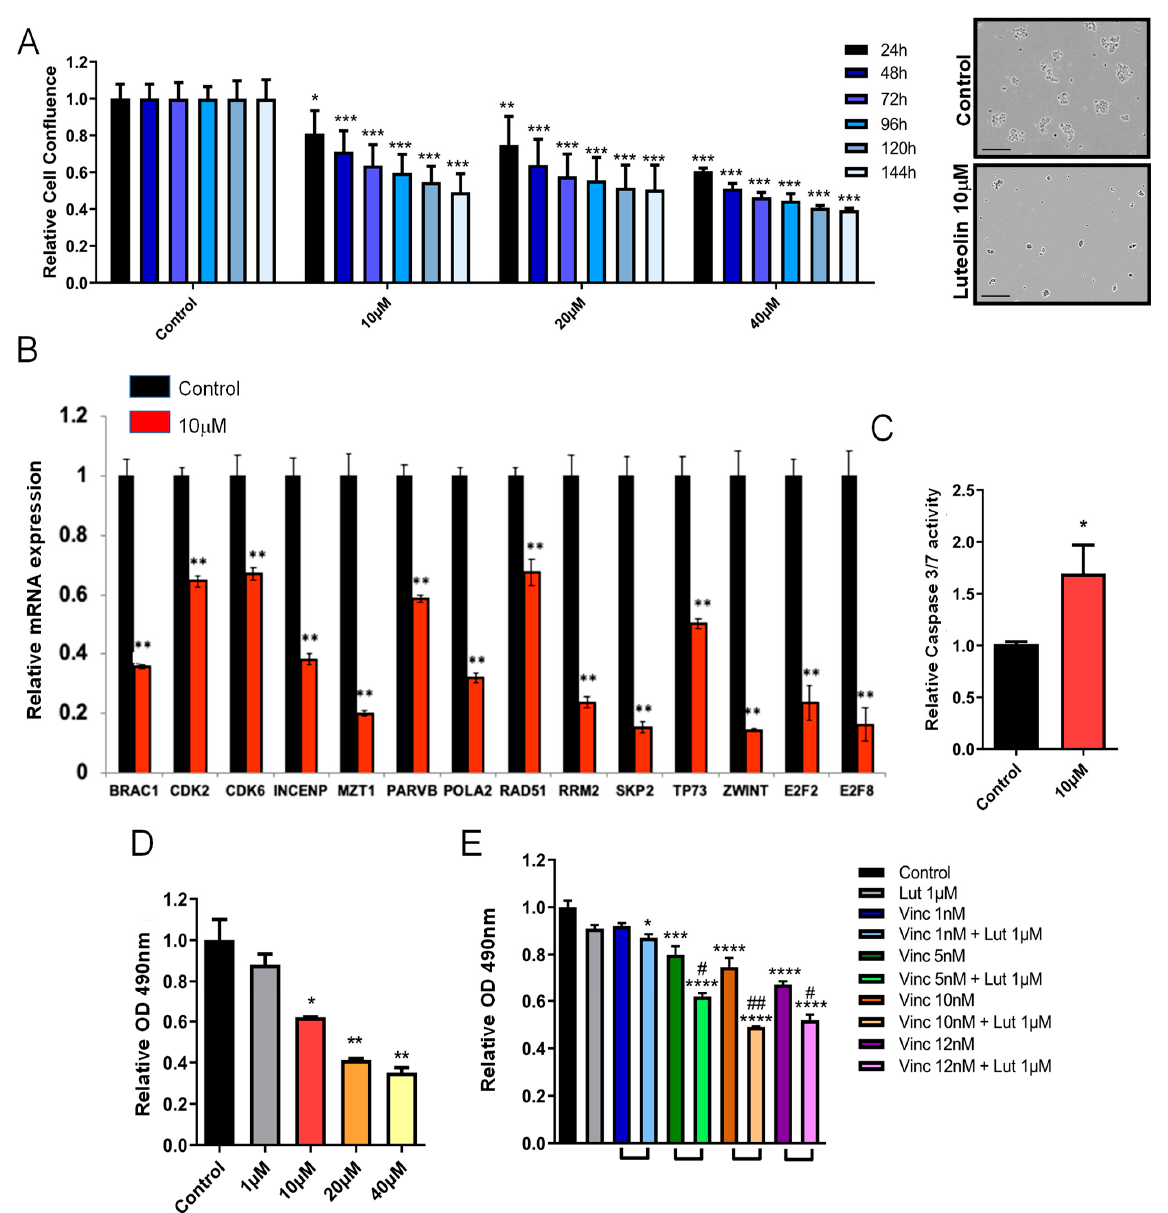
Figure 5. Musashi1 inhibitor, luteolin, impairs the growth of CHLA ‐ 01R cells . ( A ) Cell number over time of CHLA ‐ 01R cells treated with luteolin according to the automated Incucyte system and picture showing the aspect of control vs. luteolin ‐ treated cells ( B ) Expression of cell cycle/division genes by qRT ‐ PCR and ( C ) apoptosis analysis using the caspase assay after luteolin treatment (10 μ M). ( D ) Cell viability measured with the MTS assay. ( E ) Results of the MTS of cells treated with luteolin, vincristine or combination. The Combination Index (CI) for drug–drug interaction [35] was calculated and it was determined that luteolin and vincristine work synergistically. Statistical significance was calculated by one ‐ way ANOVA and t ‐ test. Data shown as means ± S.D. (* p < 0.05, ** p < 0.01, *** p < 0.001 **** p < 0.0001, # CI < 0.9, ## CI < 0.8).